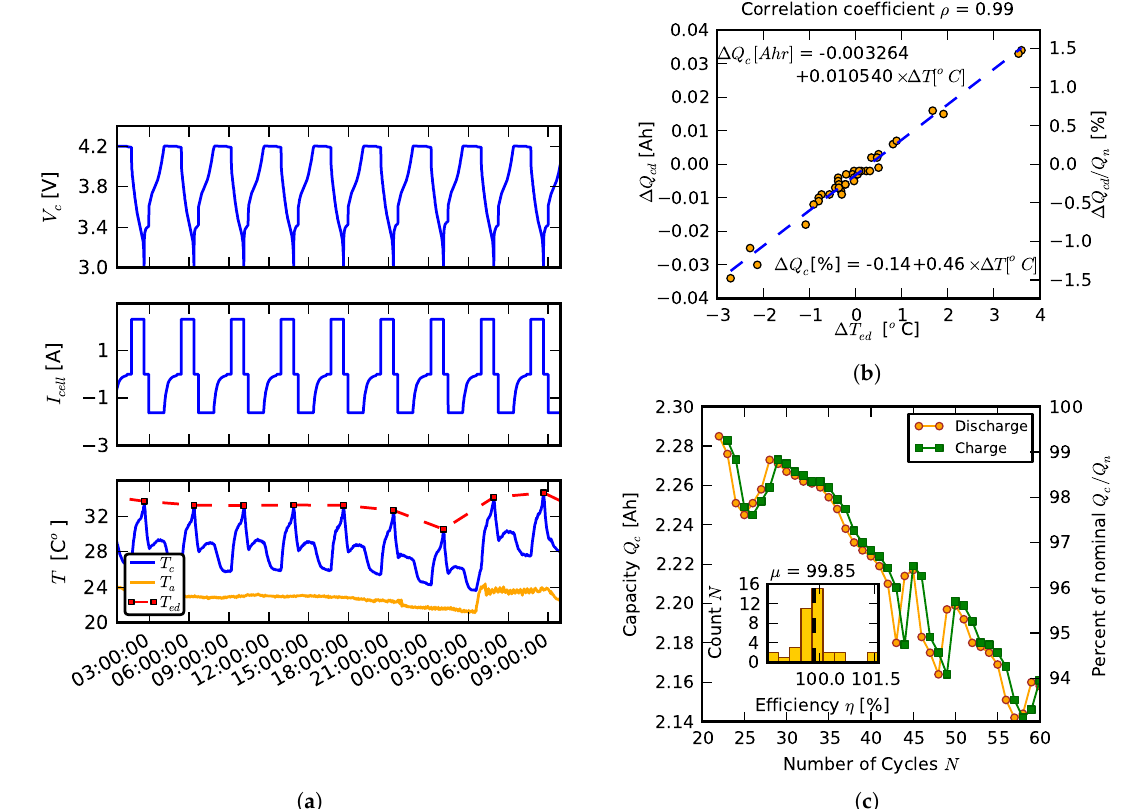
Figure 4. ( a ) characteristic waveforms for a single cell: voltage V c , current I c , temperature T c , and ambient temperature T a ; ( b ) scatter plot of change in capacity at discharge in subsequent cycles ∆ Q ∆ T ; ( c ) more details on capacity variation of a ed vs. temperature of the cell at the end of discharge single cell over time.